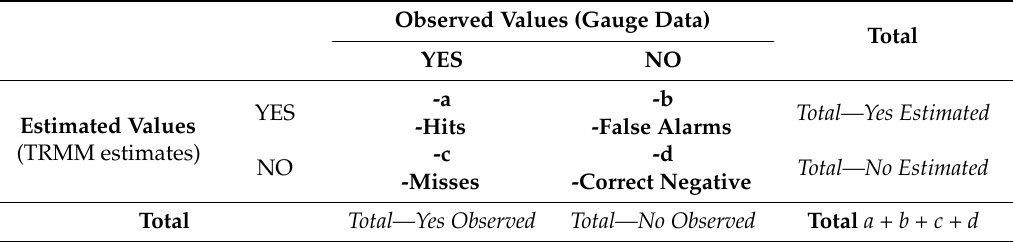
Table 2. Contingency Table 2 × 2. TRMM: Tropical Rainfall Measurement